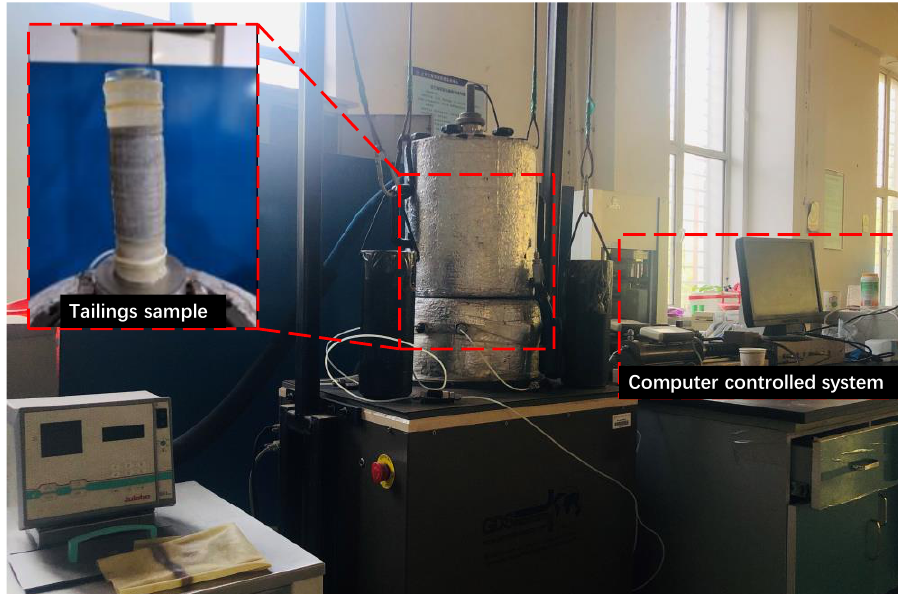
Figure 2. Permafrost triaxial testing machine.